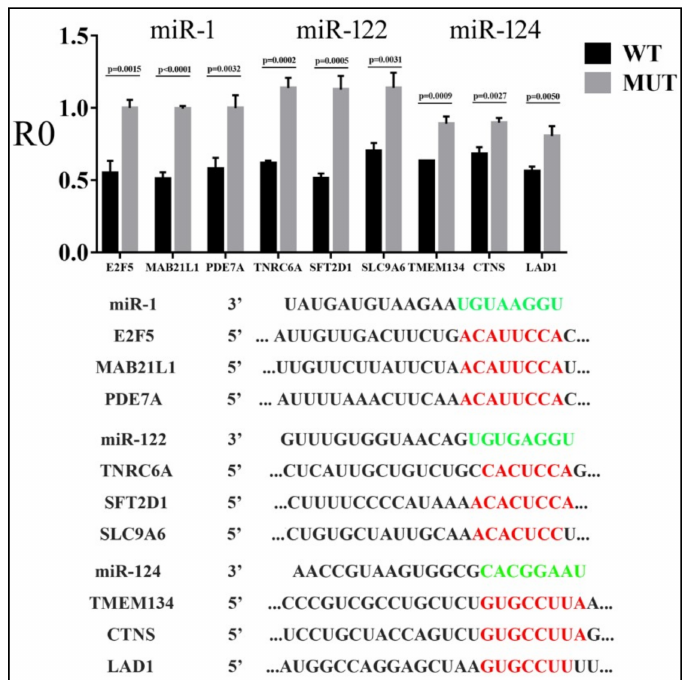
Figure 3. E ff ects of miRNAs on the expression of wildtype (WT) and mutant (MUT) target reporters in 293T cells. Y -axis is the R0 value, and x -axis represents individual genes. Averages, standard deviations, and p -values between the WT and MUT are indicated on the graph. Sequences of the miRNAs and WT targets are shown below the graph, with miRNA seed regions in green, and the complementary WT sequences deleted in MUT constructs in red.